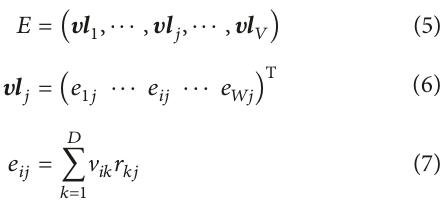
VL vector ( 𝑣𝑙 𝑗 ) is given by (6). The elements of the Term-VL matrix 𝐸 ( 𝑒 𝑖𝑗 ) are calculated by